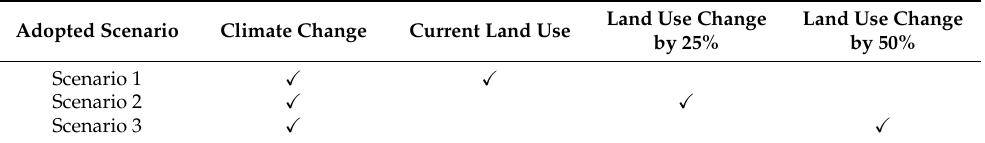
Figure 4. Flow chart of the methodology used in this study. Table 1. Description of the scenarios used in the